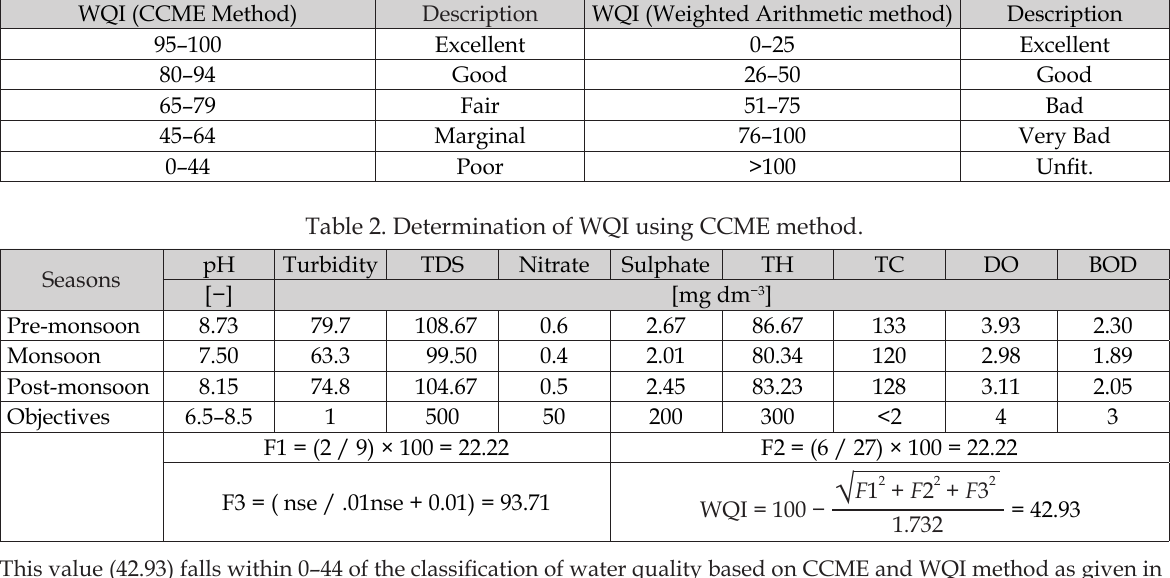
Table 1. This result indicates water quality is poor in